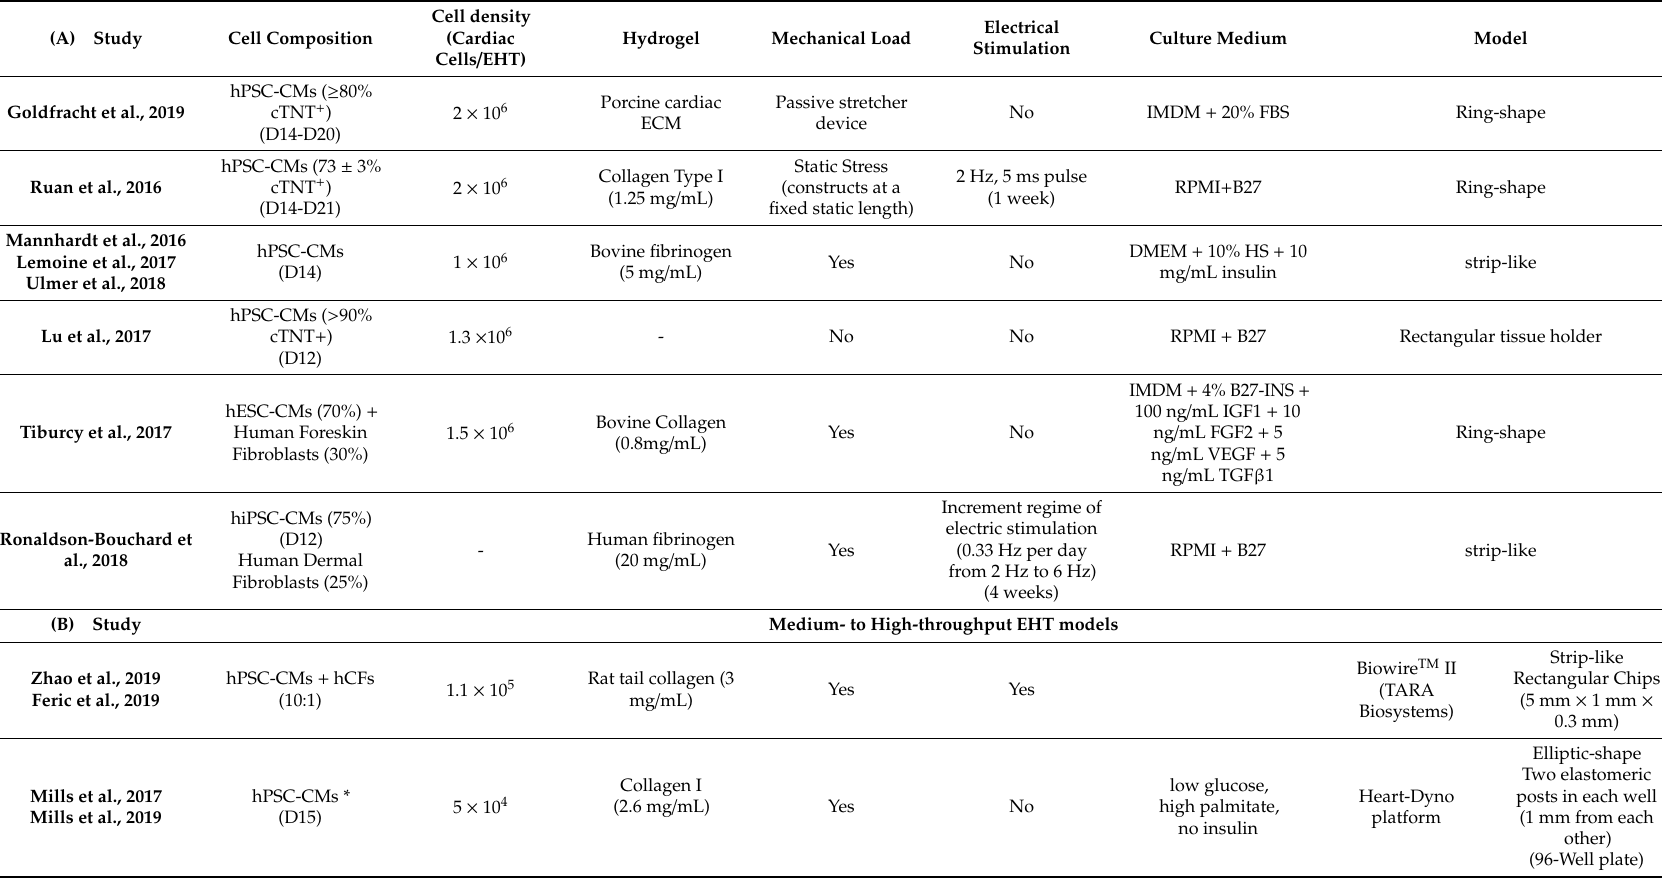
Table 2. Summary of studies reporting the generation of EHT models for in vitro applications. (A) Current strategies for the generation of EHT models, highlighting the main features of the constructs. (B) EHT models adapted to medium- to high-throughput screening setups and commercially available EHT platforms. HS, Horse Serum; FBS, Fetal Bovine